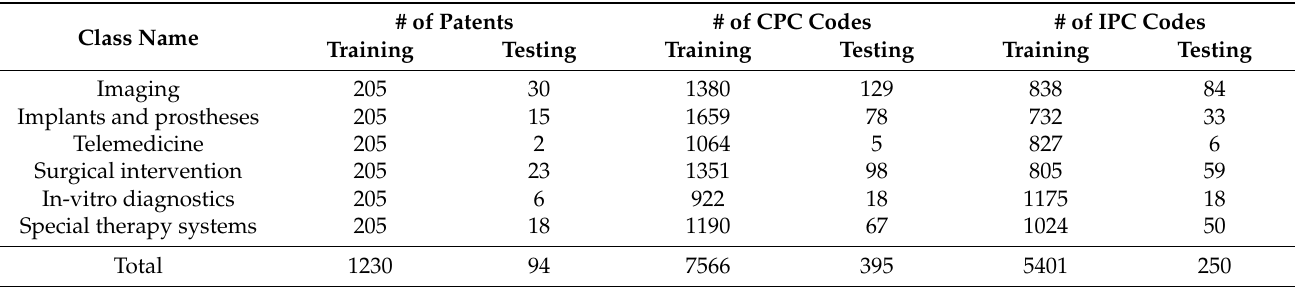
Table 1. Patent data for training and testing assigned into six classes of innovative biomedical devices.